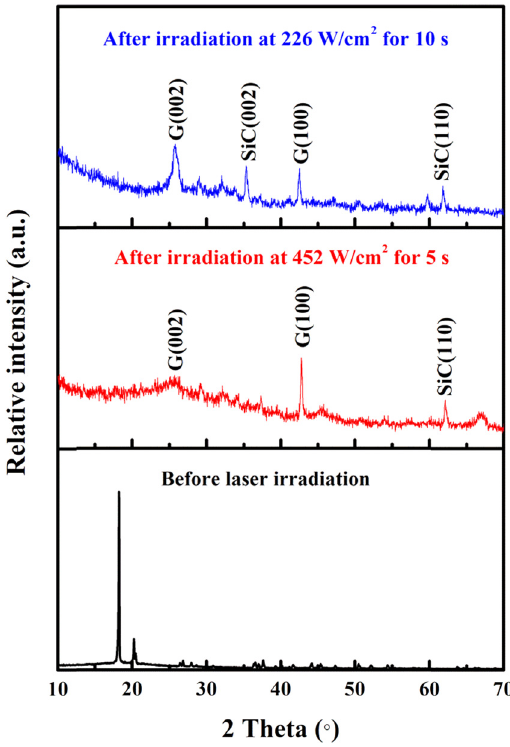
Figure 5: The surface XRD spectra of quartz/epoxy composite.